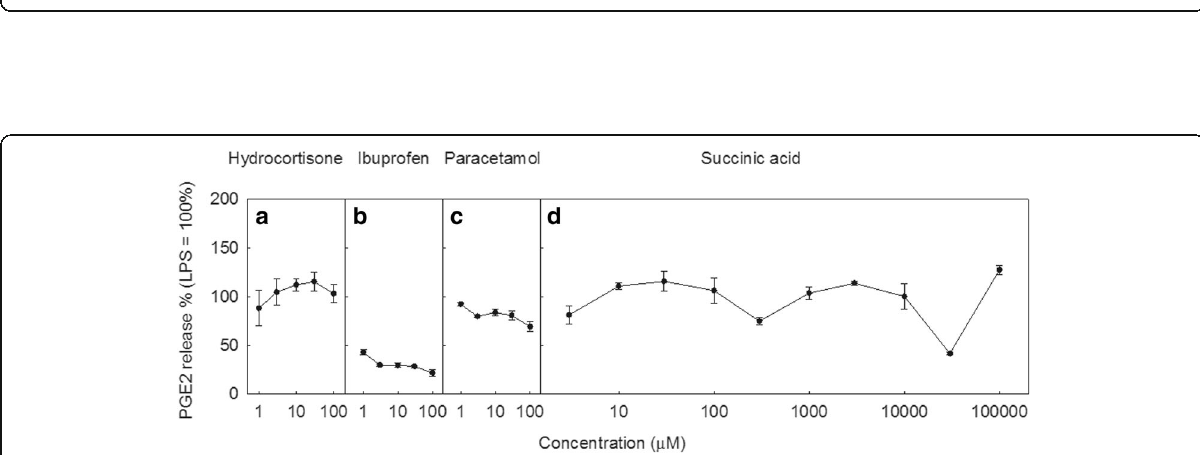
Fig. 5 The effects of succinic acid and anti-inflammatory drugs on PGE2 production. THP-1 human macrophage cells were stimulated with LPS in the presence of the indicated concentrations of each drug and the production of PGE2 was measured by ELISA after 20 h of stimulation was measured by ELISA. Results are presented on a scale that is normalised against results for LPS-only cells. Culture supernatant concentrations of PGE2 from macrophages treated with hydrocortisone ( a ), ibuprofen ( b ), paracetamol ( c ) or succinic acid ( d ). Points represent mean ± SE of 3 independent